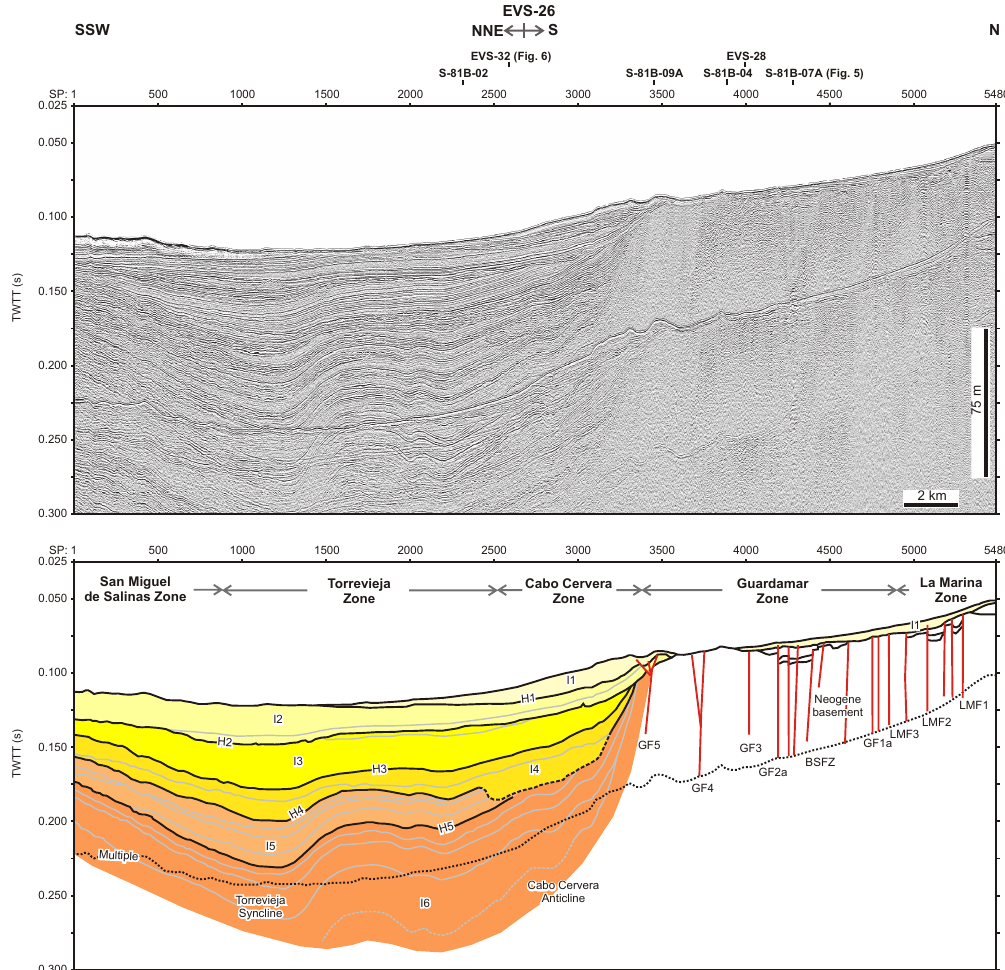
Fig. 6. SCS sparker profile EVS-26 and relative line drawing showing the seismo-stratigraphic units and structures. Note how the folding affects unit I3 and some reflectors at the base of unit I2 in the Torrevieja zone and that some faults affect unit I1 in Guardamar and La Marina zones. See location of profile in Figs. 2 and